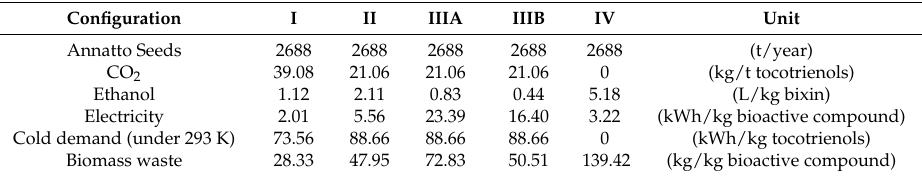
Table 3. The consumption of resources and the biomass waste generated by the configurations